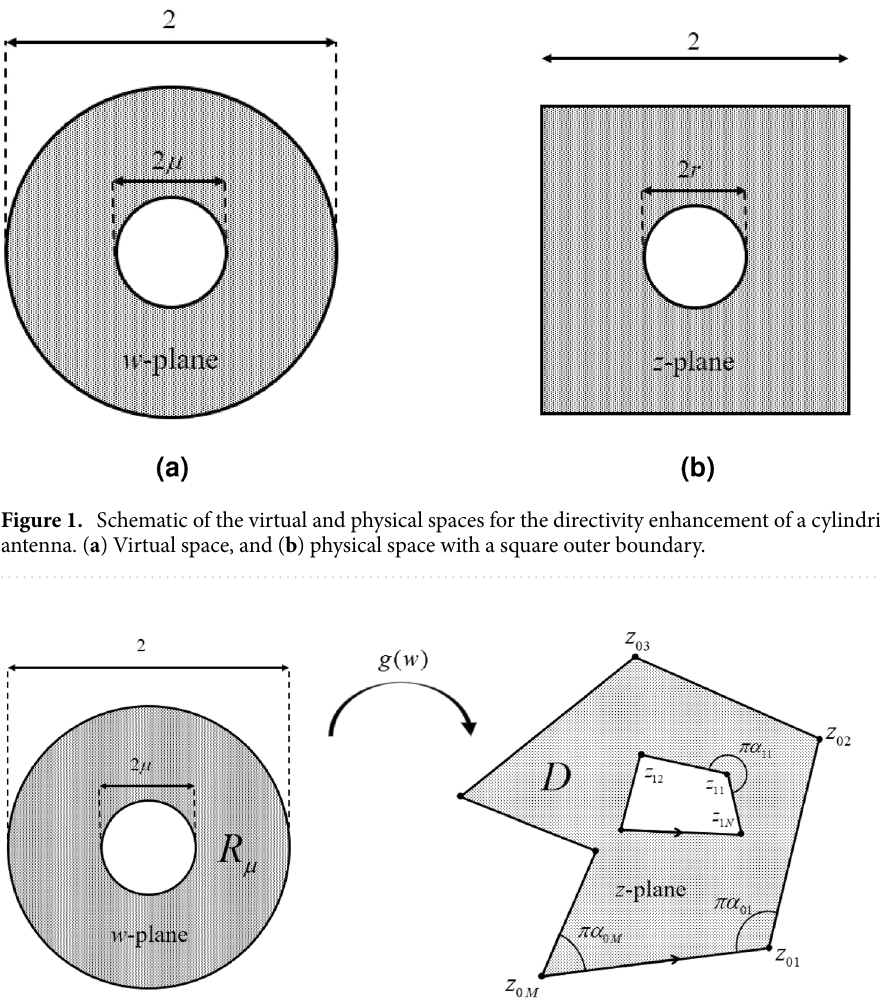
Figure 2. The illustration of the geometries associated with the conformal mapping from the annulus R µ to the doubly connected polygon D